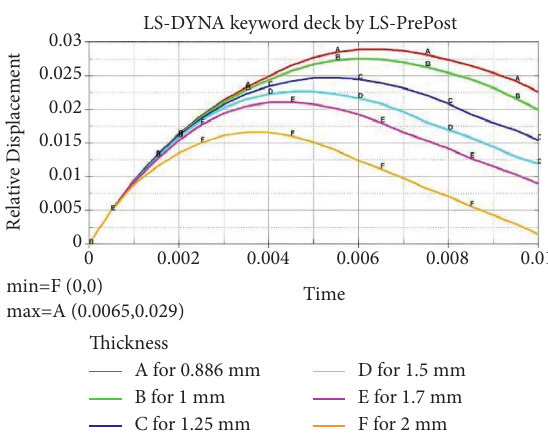
Figure 11: Deformation of diferent beam